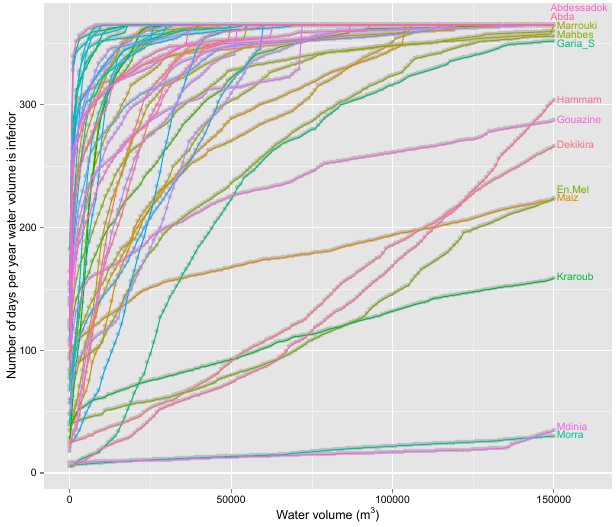
Figure 17. Number of days for each lake that water volumes fell below a designated volume (up to 150,000 m 3